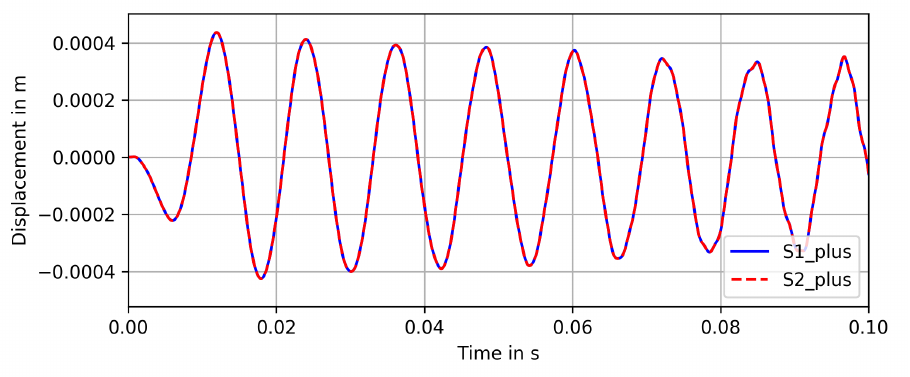
Figure 12. Displacement signal of sensor position S1_plus and